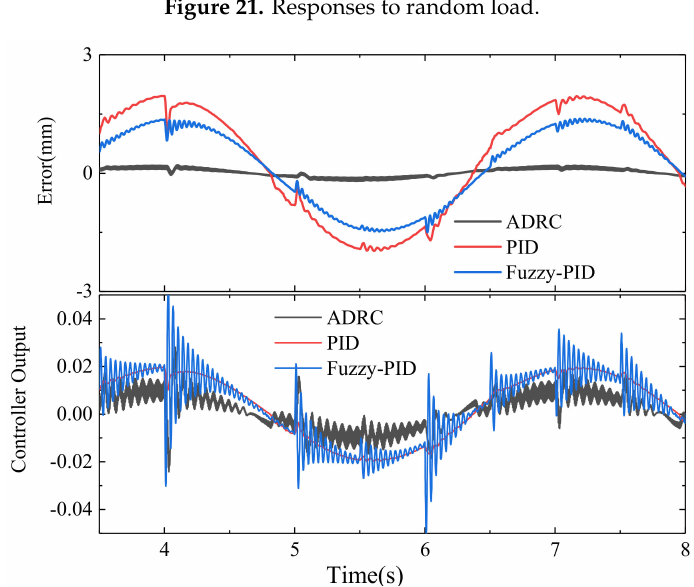
Figure 21. Responses to random load.